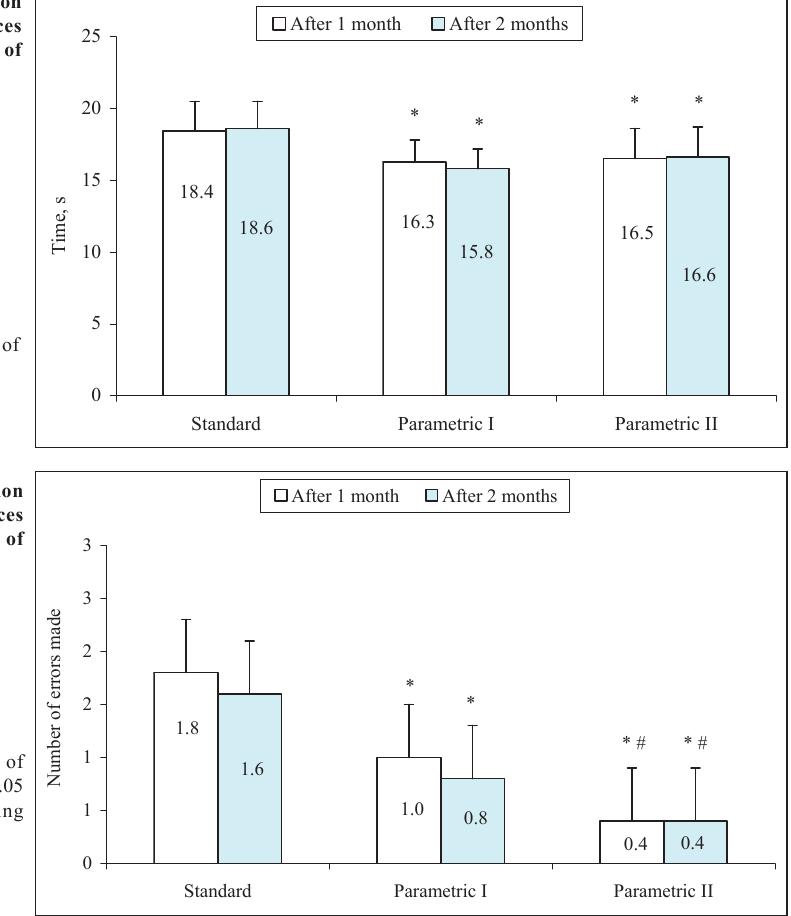
Note. *— p < 0.05 compared to the indices of standard teaching group in 1 month; # — p < 0.05 compared to the indices of standard teaching group in 2